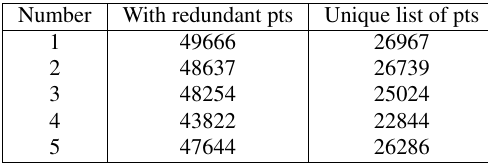
Table 2: Description of subsets. Points are called redundant